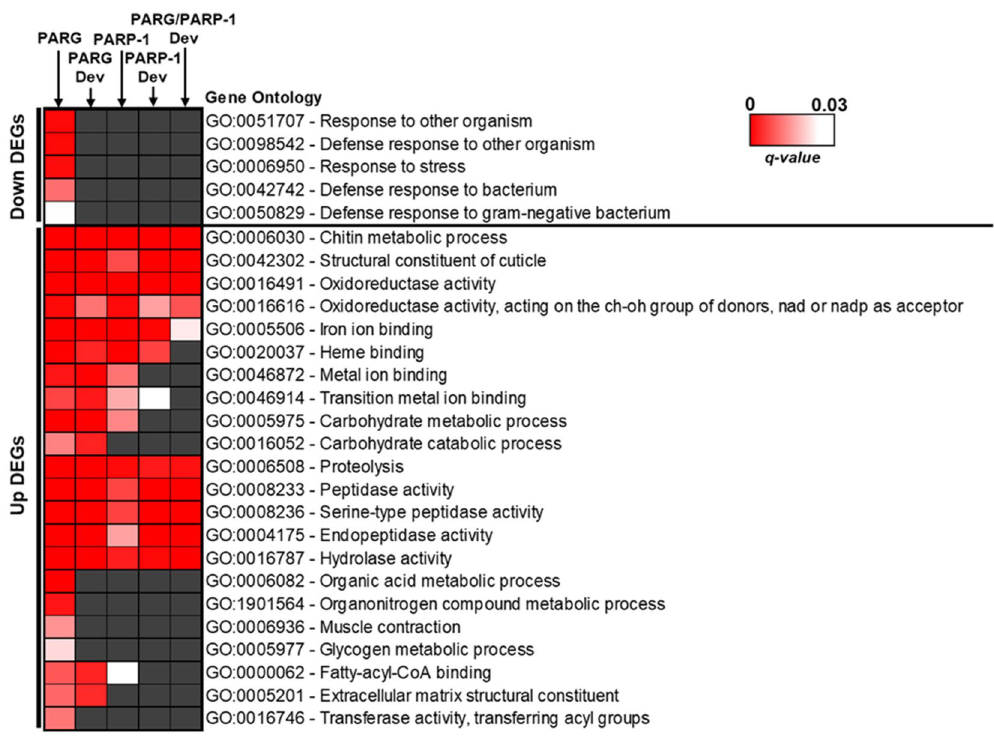
Figure 5. PARG and PARP-1 DEGs are involved in specific functions. Overview of the main Gene Ontology- terms (GO-terms) overrepresented among DEGs. The upper part corresponds to the downregulated DEGs, while the lower part corresponds to upregulated DEGs. The left part corresponds to a heatmap of the FDR- corrected p -value (q-value) associated with the different GO-terms. The red-to-white shaded tiles correspond to GO-terms that are significantly overrepresented among DEGs, while dark gray tiles correspond to GO-terms not significantly enriched. The left column, titled “PARG”, includes the 215 PARG downregulated DEGS and the 797 upregulated DEGs. The second column, titled “PARG Dev”, is a subtype of the first column that included the 146 PARG downregulated DEGs that should be upregulated through development and